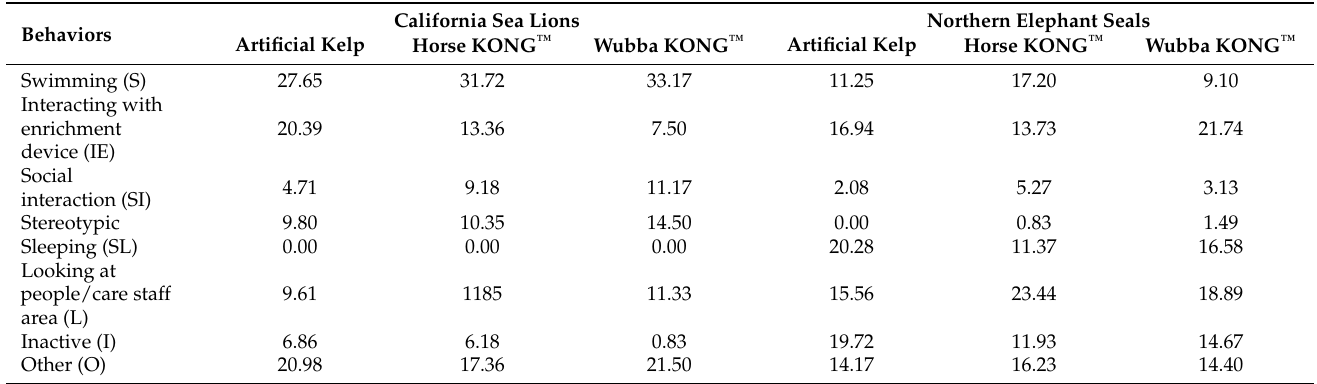
Table 4. Percentages of behaviors expressed by California sea lions and northern elephant seals during the presentation of environmental enrichment devices (Wubba Kong ™ , Horse Kong ™ and Artificial Kelp).